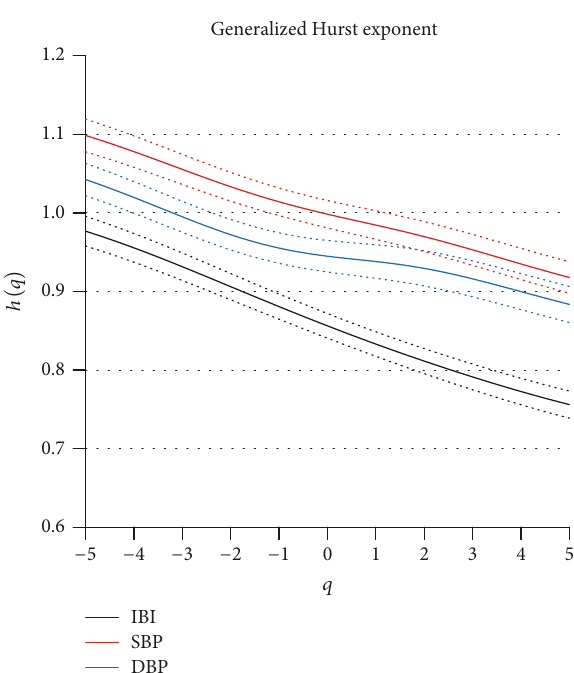
Figure 12: Generalized Hurst exponents, ℎ(𝑞) , for IBI, SBP, and DBP . Mean and 95% confidence intervals over the group of 𝑁 = 84